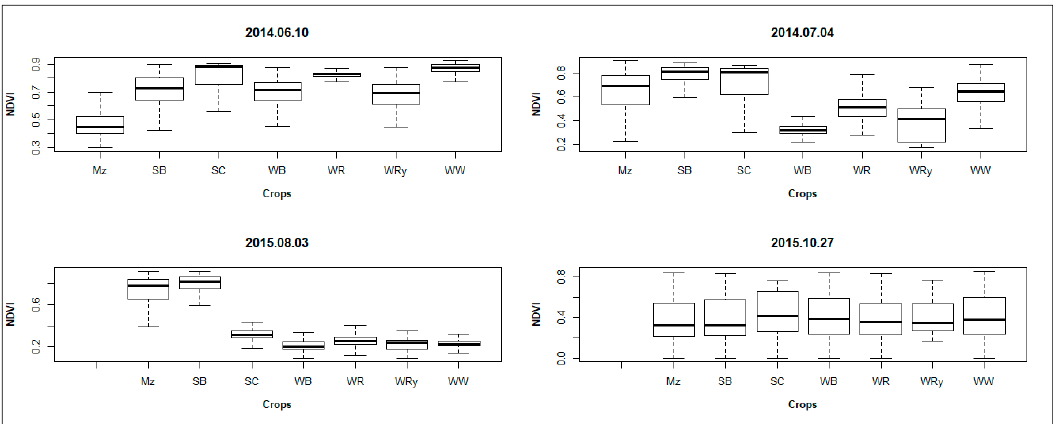
Figure A2. Mean and variance NDVI comparisons between Sentinel 2 and Landsat 7 images; there was no significant difference between the means ( p = 0.47) in these two closely sensed data. Correlation coefficient was r = 0.97. Values are the averages of each parcel ( n = 1130 parcels) from 2016 IACS data extracted using the R package “raster.”.